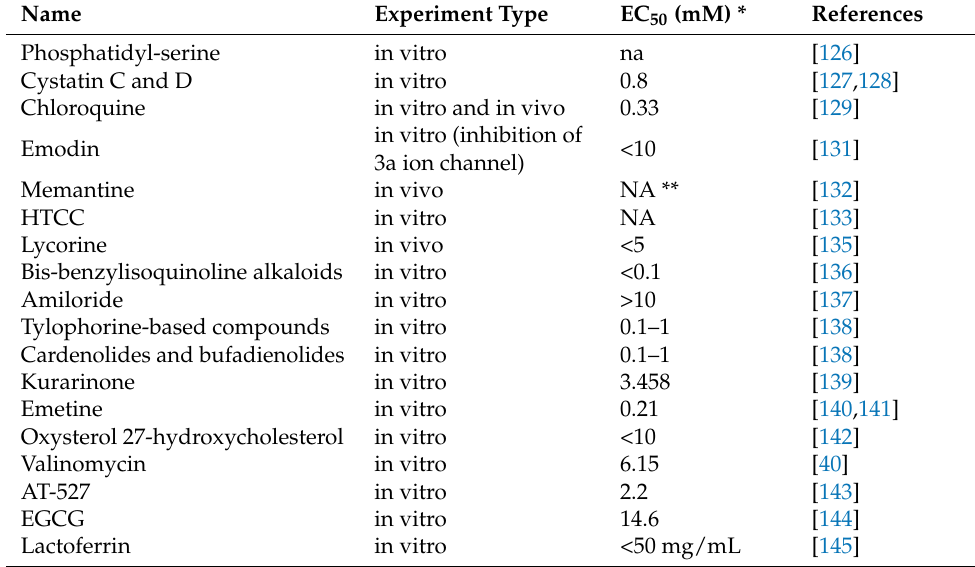
Table 3. Anti-coronavirus candidate molecules identified by using the HCoV-OC43 infection